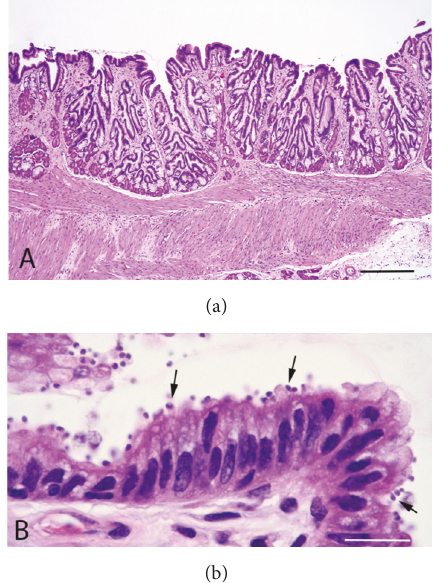
Figure 3: (a) Low power magnification image of chronically inflamed stomach with hyperplasia of surface and glandular epithe- lium. H&E stain; bar = 142 𝜇 m. (b) High power magnification image of hyperplastic gastric glandular and surface epithelium with protozoa (arrows) closely associated with the apical surface membranes of the epithelial cells. Other protozoa are free in the lumen. H&E, bar = 14 𝜇